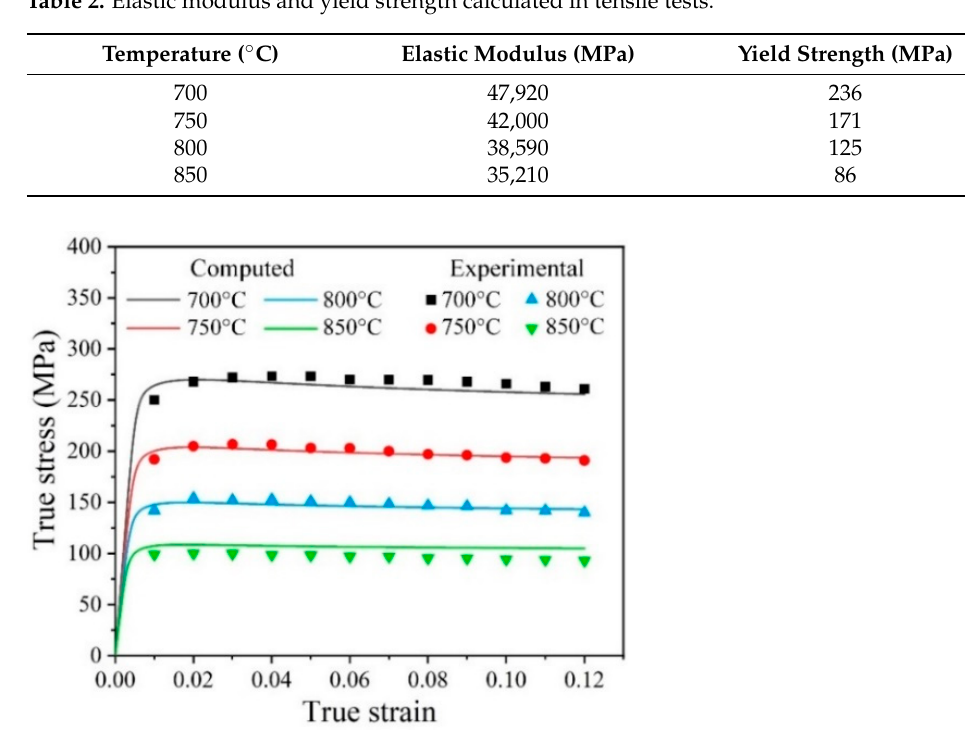
Figure 3. Comparisons of the experimental (symbols) and computed (solid curves) results at different temperatures with the same strain rate (10 − 3 s − 1 ).